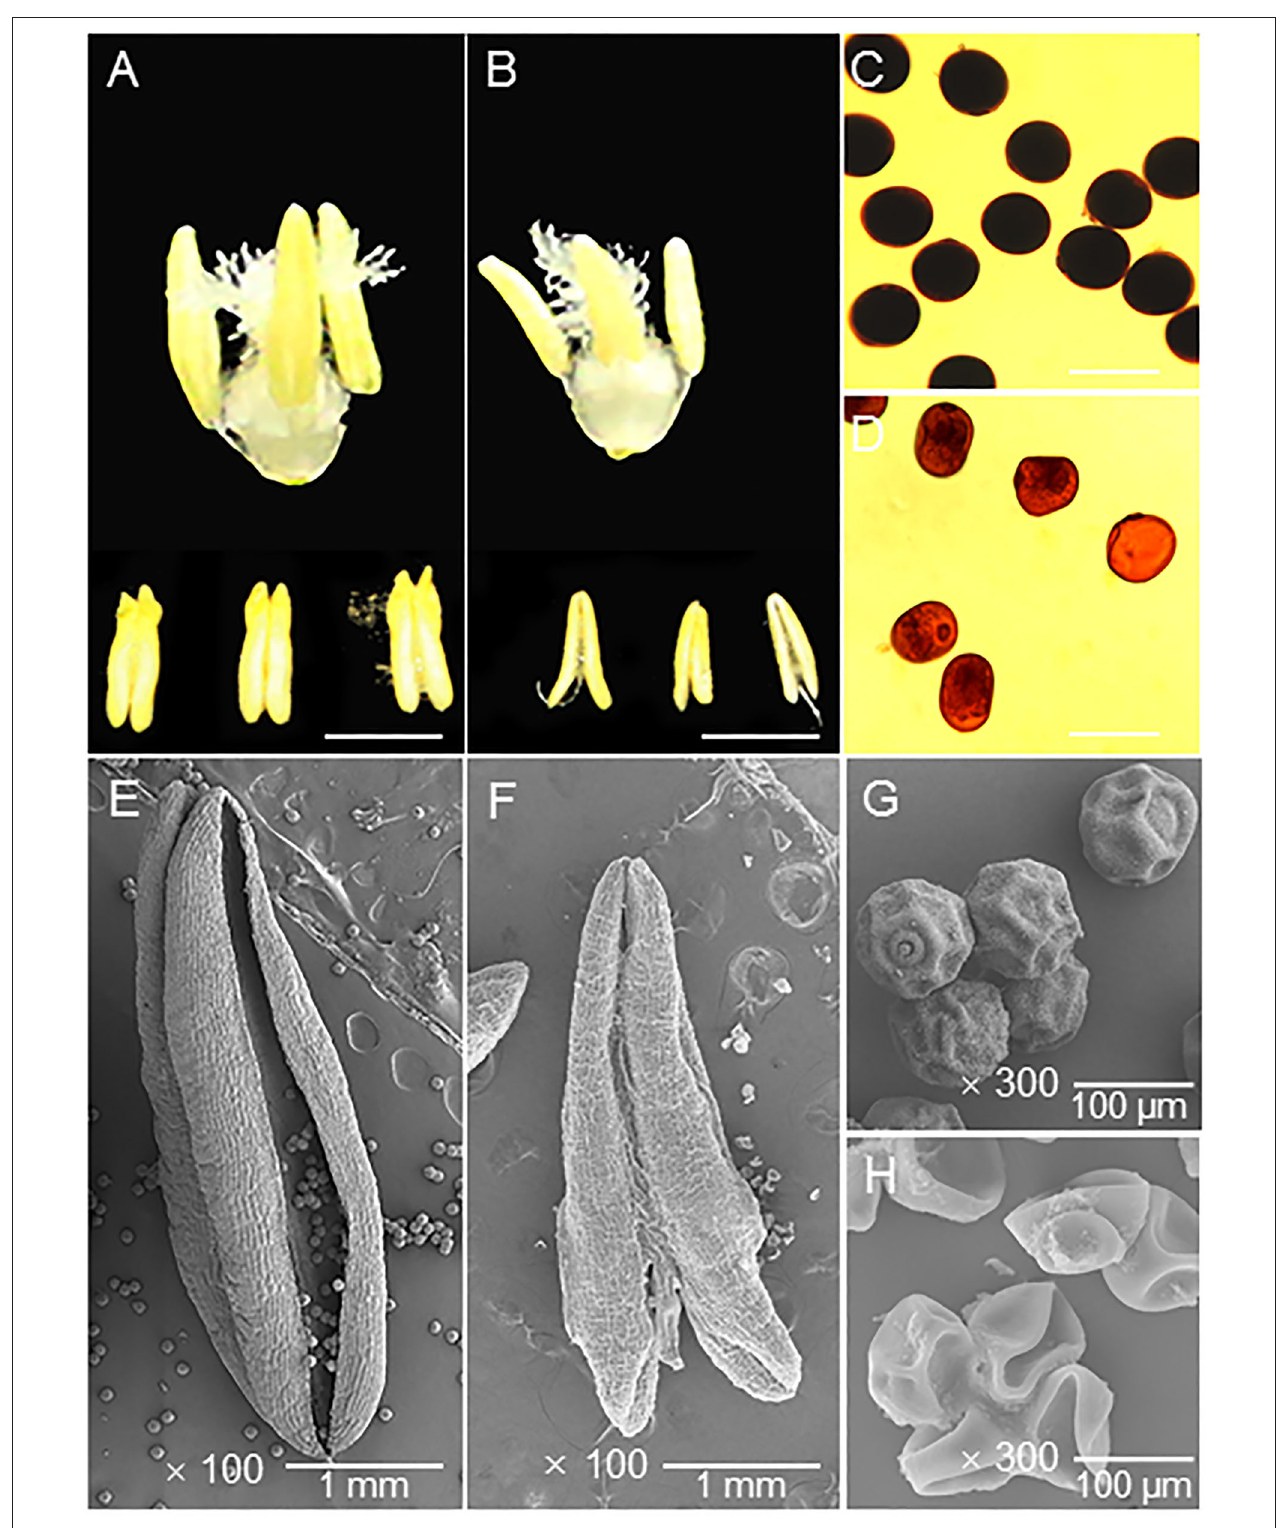
FIGURE 2 | Appearance of the trinuclear stage anther and pollen grain in Normal and HT-ms plant. (A) The morphology of Normal trinuclear stage anthers. (B) The morphology of HT-ms trinuclear stage anthers. (C) Pollen grains from a Normal plant stained with potassium iodide iodine (KI-I 2 ) solution. (D) I 2 -KI-stained pollen grains from an HT-ms plant. (E,F) The outermost surface of the epidermis of Normal (E) and HT-ms (F) anthers under scanning electron microscopy (SEM). (G,H) SEM analysis of pollen grains from Normal (G) and HT-ms (H) plants. Bars = 2mm in A,B , 100 µ m in C,D , 1mm in E,F , and 100 µ m in G,H .